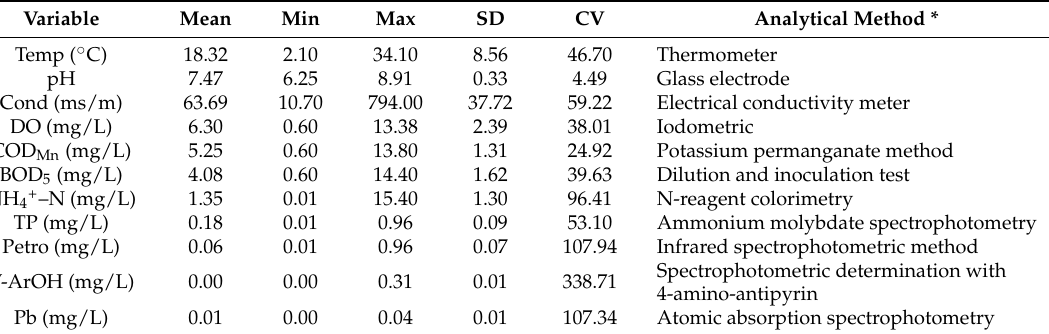
Figure 1. Study area and its monitoring sites. Table 1. Univariate statistics and analytical methods in the analysis of the water quality variables for rivers surrounding Lake Taihu. SD and CV stand for standard deviation and coefficient of variation, respectively. Temp, temperature; Cond, conductivity; DO, dissolved oxygen; COD Mn , chemical oxygen demand; BOD 5 , chemical oxygen demand; TP, total phosphorus; Petro, total petroleum hydrocarbons; V-ArOH, volatile phenol.